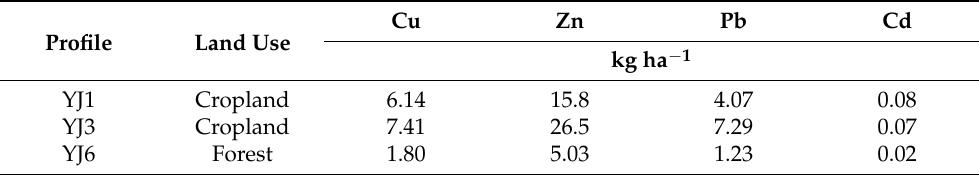
Table 5. Accumulation amounts of heavy metals for different land uses with a distance of 50 m from the edge of the Yanjiang expressway.